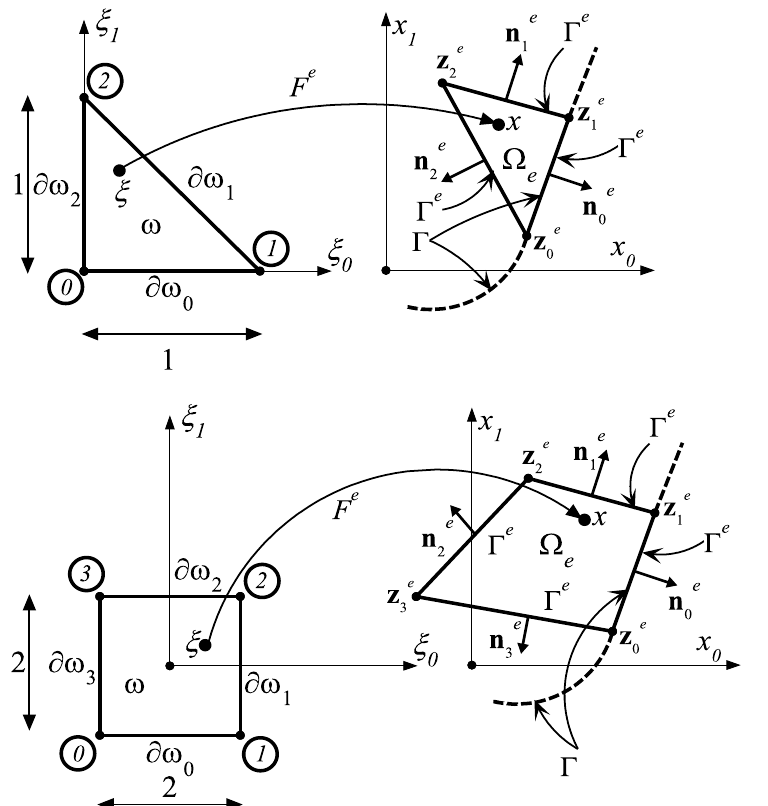
Figure 3. The mapping F e defining the relation between the triangular and quadratic master element ω (on the left) and arbitrary current finite element Ω e (on the right). The derivative of this mapping is a linear operator represented by the